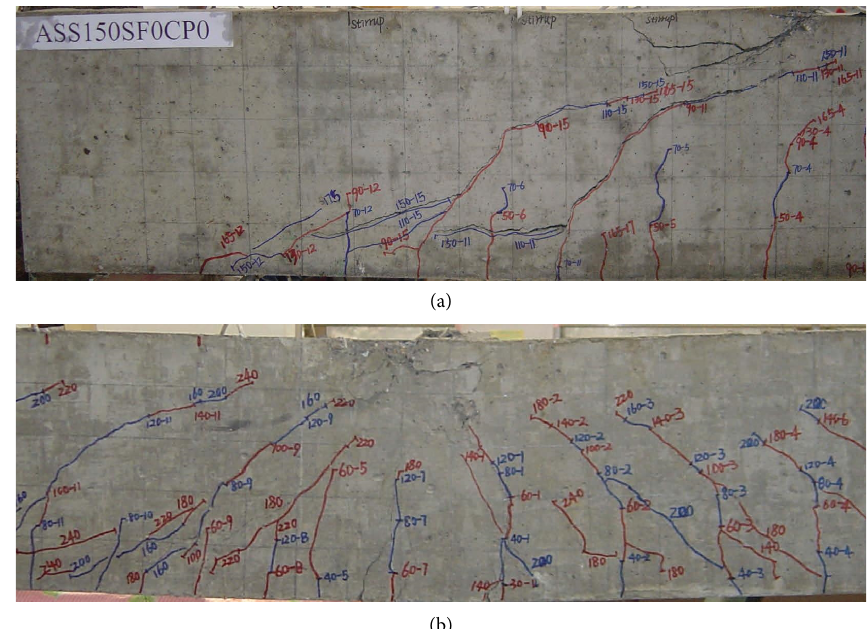
Figure 8: Crack pattern and failure mode of beams BSS150SF0PF0 and BSS150SF40PF4. (a) Shear failure and crack pattern of beam BSS150SF0PF0. (b) Flexure failure and crack pattern of beam BSS150SF40PF4.